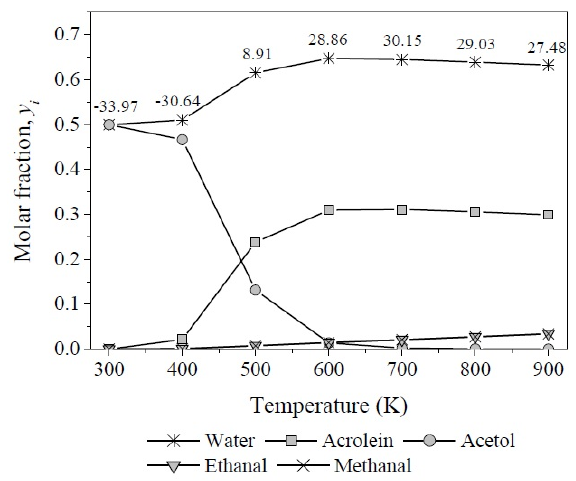
Figure 13. Molar fractions of products as function of reaction temperature of glycerol dehydration.